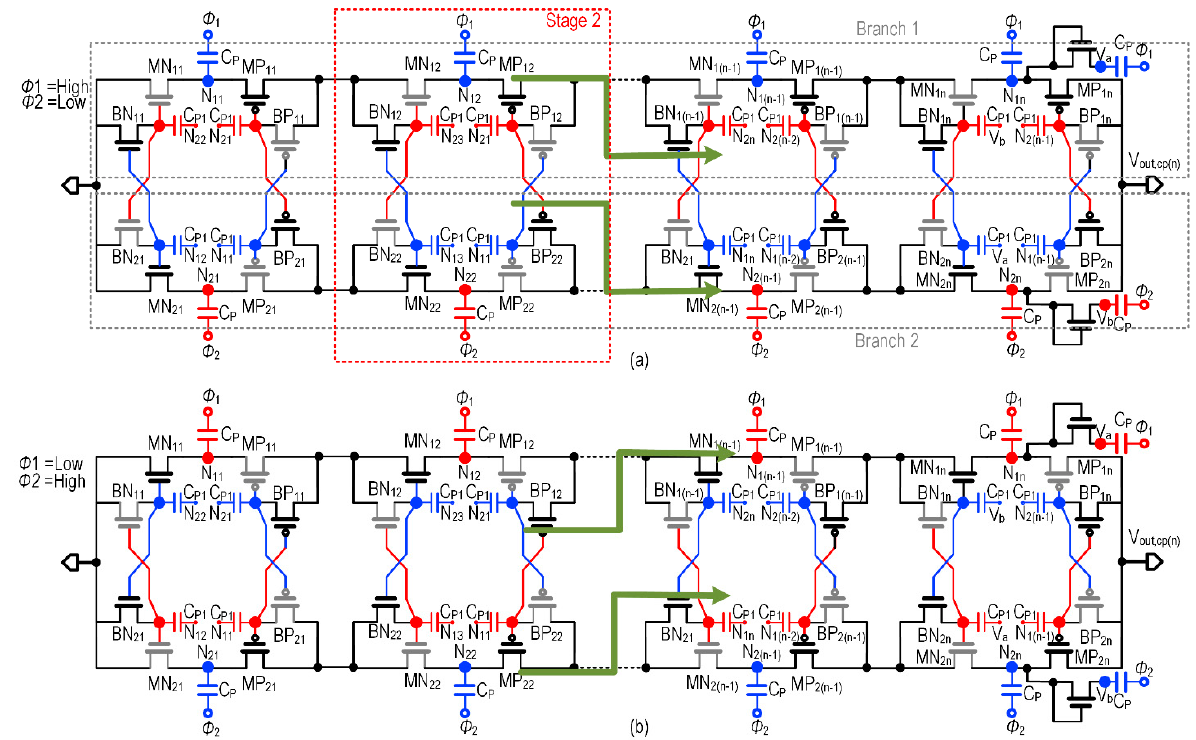
Figure 9. Schematic of the proposed charge pump: ( a ) operation in Cycle 1 ( b ) operation in Cycle 2. The gate voltages of (MN 12 , BN 22 ), (MN 22 , BN 12 ), (MP 12 , BP 22 ), and (MP 22 , BP 12 )